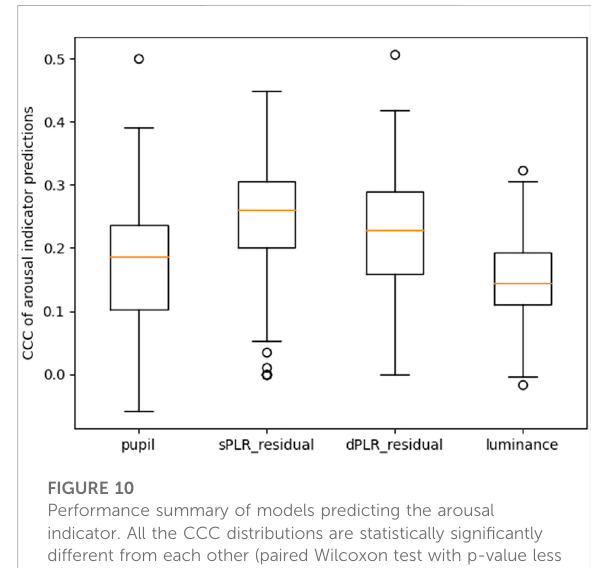
FIGURE 9 Performance summary of models predicting the derivative of luminance.AlltheCCCdistributionsarestatisticallysigni fi cantlydifferent from each other (paired Wilcoxon test with p-value less than 0.001).